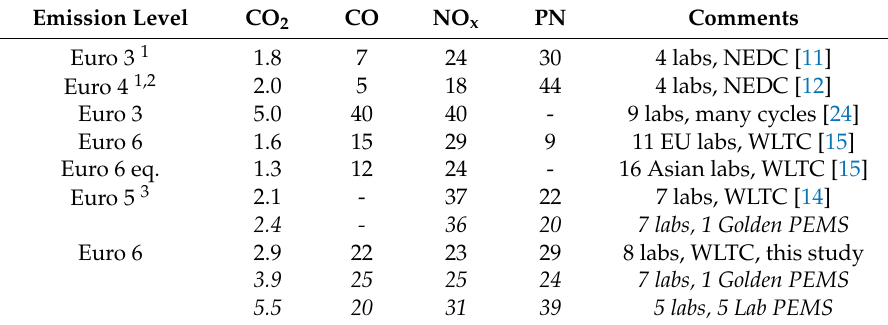
Table 3. Reproducibility levels (%) from inter-laboratory exercises with gasoline vehicles. In italics values based on PEMS.